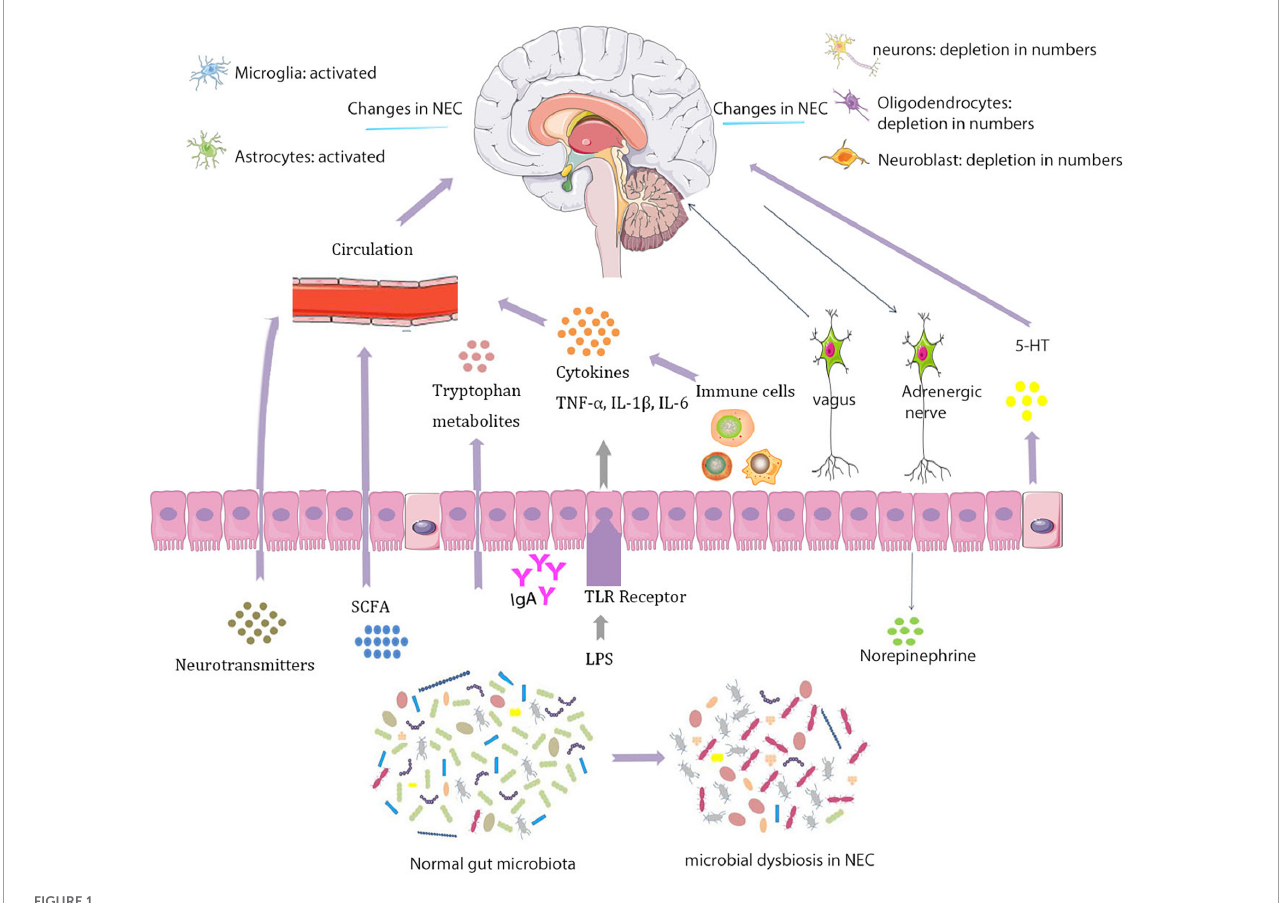
FIGURE1 Interactions between the microbiota and nervous systems in necrotizing enterocolitis